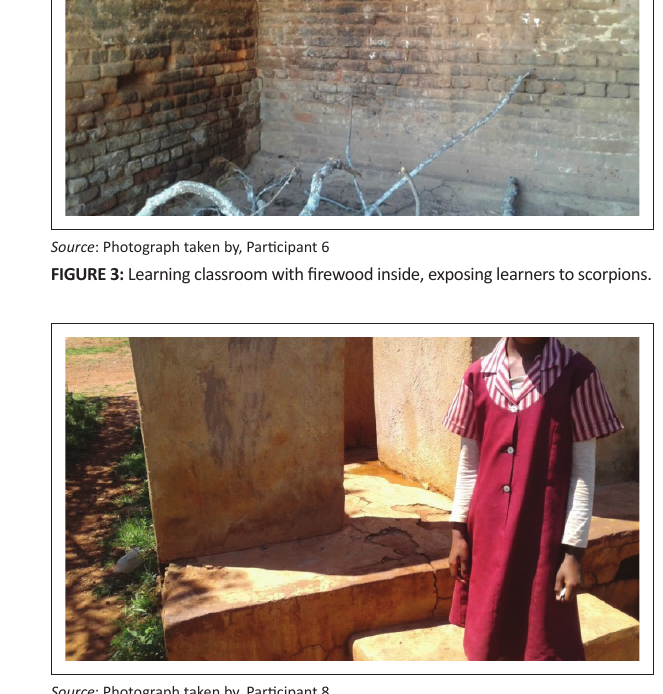
Source : Photograph taken by, Participant 4 FIGURE 2: Learners learning sitting on the school grounds.